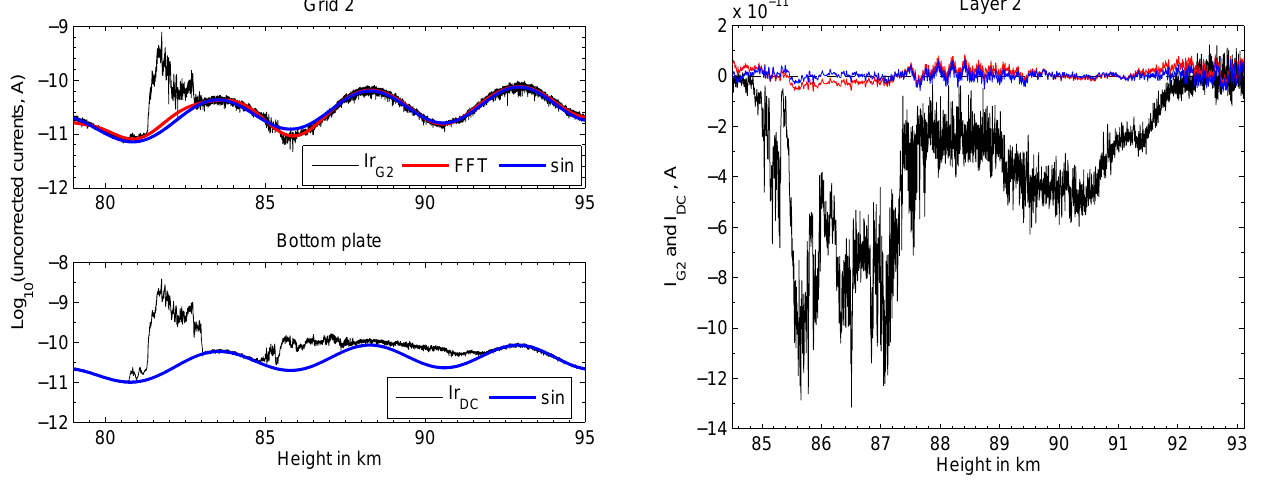
Fig. 5. As for Fig. 4 but now for layer 2, the upper PMSE